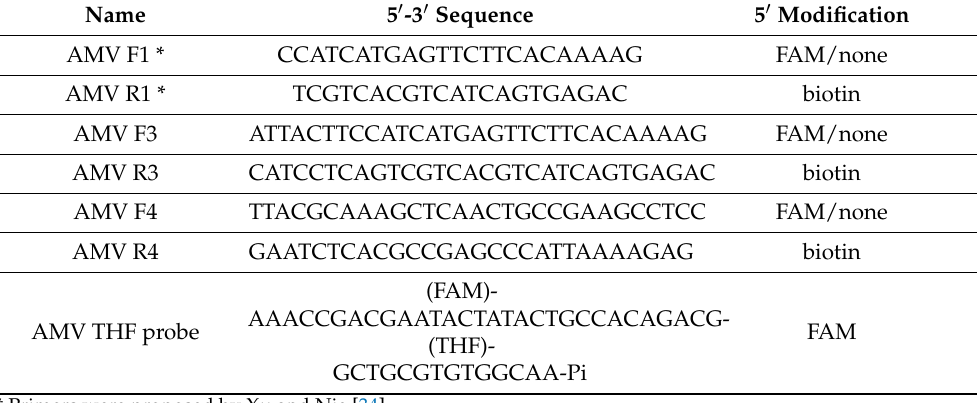
Table 1. Sequences of primers used in the